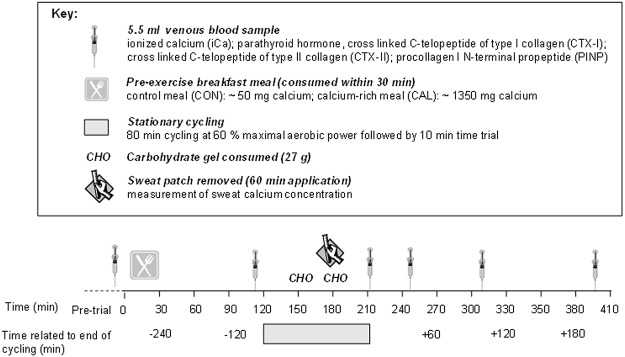
Schematic overview of study design.